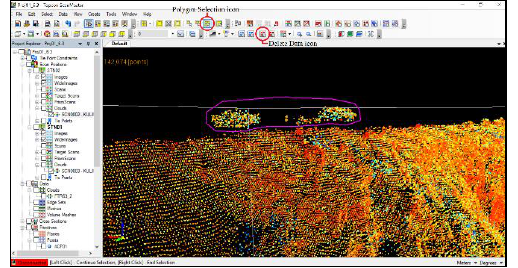
Figure 33. Unnecessary scanned data was selected using Polygon Selection icon and was deleted using Delete Data icon on toolbar